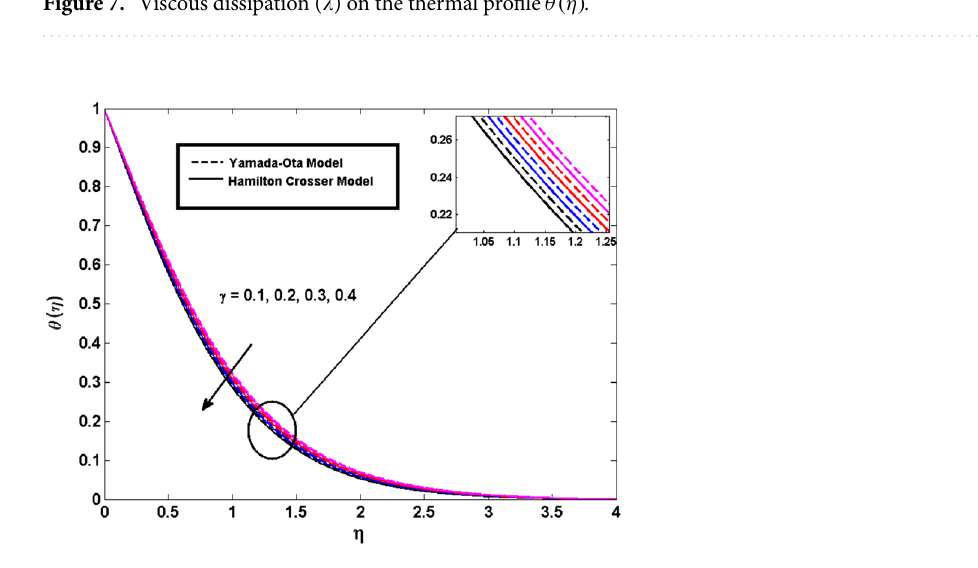
Figure 7. Viscous dissipation ( (cid:31) ) on the thermal profile θ(η) .